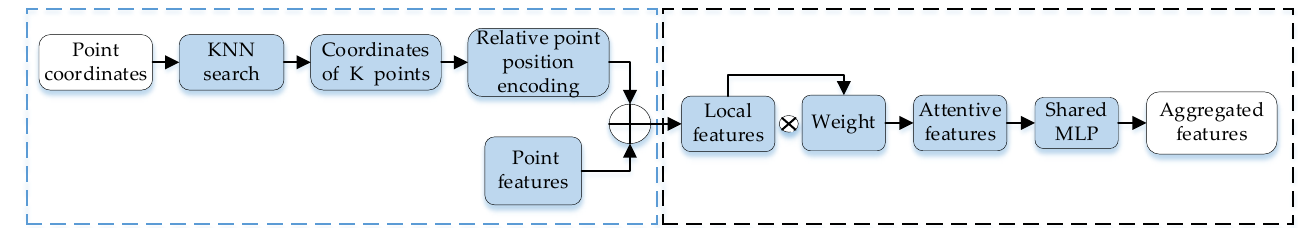
Figure 3. Local feature attentive module (LFA).